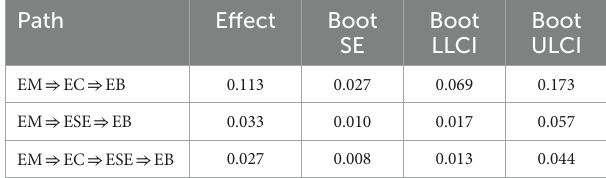
TABLE 5 Mediating effect and effect size.